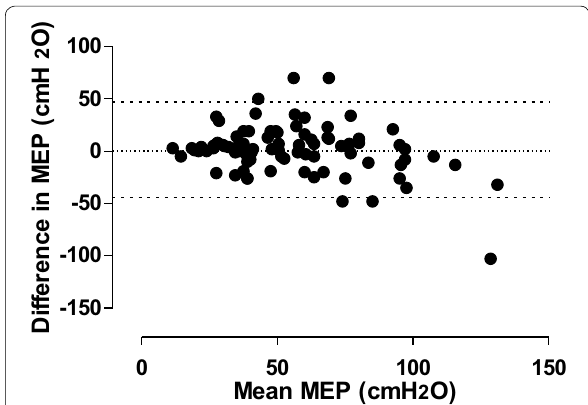
Fig. 2 Bland–Altman analysis of maximal expiratory pressure correla- tions: difference versus